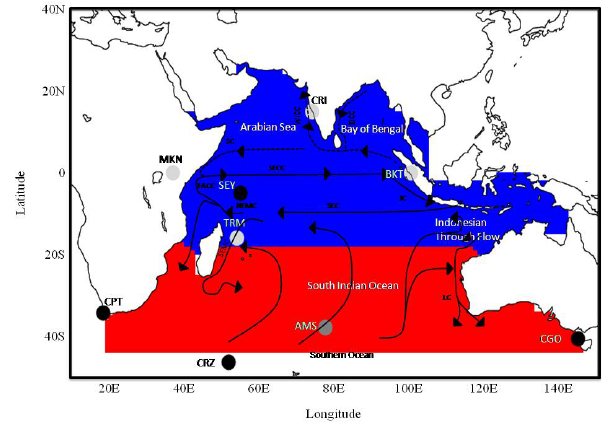
Fig. 1. Sub-regions of the Indian Ocean (30 ◦ N–44 ◦ S, red and blue combined) used in this paper: northern Indian Ocean (blue), south- ern Indian Ocean (red). The water column circulation pattern is also given. East India Coastal Current (EICC), West India Coastal Current (WICC), Somali Current (SC), South Equatorial Counter- current (SECC), East African Coastal Current (EACC), northern East Madagascar Current (NEMC), southern East Madagascar Cur- rent (SEMC), South Equatorial Current (SEC), South Java Cur- rent (JC) and Leeuwin Current (LC) (Schott and McCreary, 2001). The currents shown in dashed line represent boreal winter, and these currents flow in the opposite direction during boreal sum- mer. Overlain also is the network of atmospheric observations of CO 2 – Cape Rama, India (CRI); Mount Kenya (MKN); Bukit Koto Tabang (BKT); Seychelles (SEY); Tromelin Island (TRM); Cape Point (CPT); Amsterdam Island (AMS); Cape Grim Observatory (CGO); Crozet Island (CRZ). The color of the dot indicates how many inversions used data from that location (black: all or almost all inversions; dark grey: around half the inversions; light grey: one or two inversions). We note that the temporal period over which the atmospheric data were collected is not the same for all the